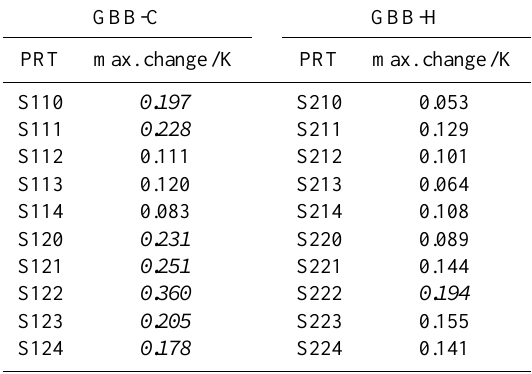
Table 5. Maximum individual change of the fitted calibration char- acteristics for each PRT between the calibration campaigns in Jan- uary 2012 and January 2013. Changes of less than 170mK (cor- responding to the target radiance uncertainty of 1% of GLORIA measurements) are shown in regular typeface, whereas changes of less than 500mK (corresponding to the minimum radiance uncer- Fig. 20. The same calibration curves as in Fig. 12 are shown in red. Additionally, the deviations of the measured radiation temperatures of tainty requirement of 3% of GLORIA measurements) are shown in 2012tothepolynomialfitof2013areshownasasecondcurveinblueineachpanel. (a) illustrateswithPRTS124atypicalcaseofmoderate italic typeface. changes whereas (b) illustrates with PRT S210 a typical case of small changes.